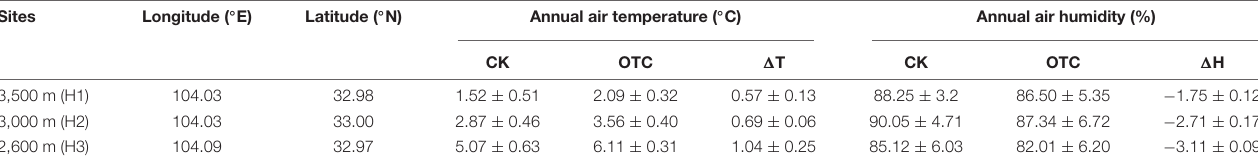
TABLE 1 | The details of experimental plots and treatments.